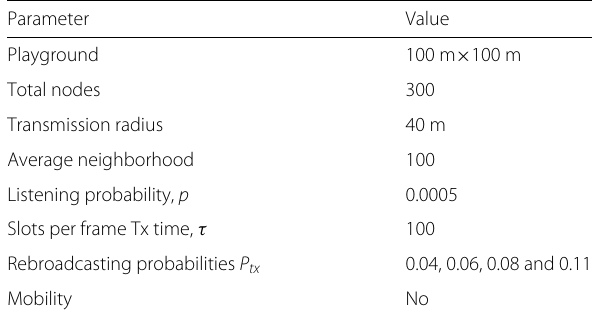
Table 7 Parameter set for the reachability analysis of an example MANET Parameter